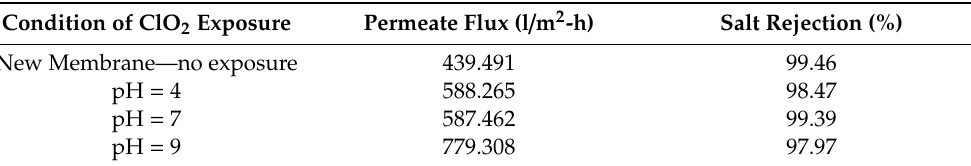
Table 18. Performance of a new Toray TM820H-400 (Toray, Japan) seawater membrane and when exposed to 100 ppm-hours of chlorine dioxide (5-h exposure at 20 ppm) at 49 bar and 25 ◦ C. Testing